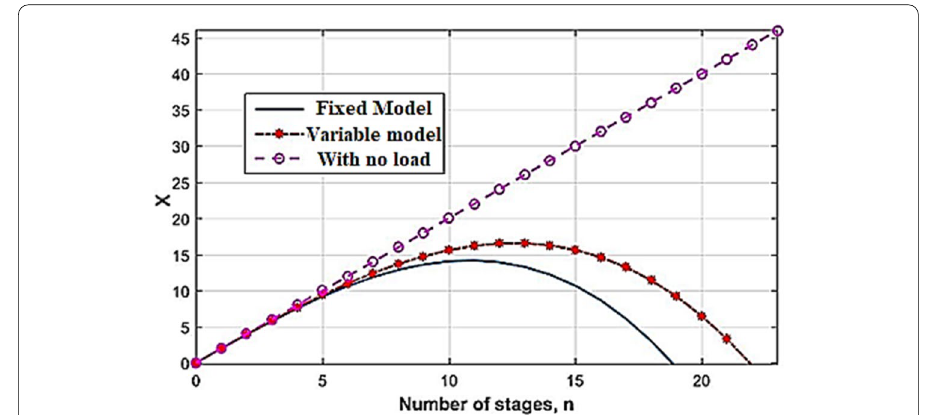
Fig. 2 The gain X as a function of the Number of stages, n for the different